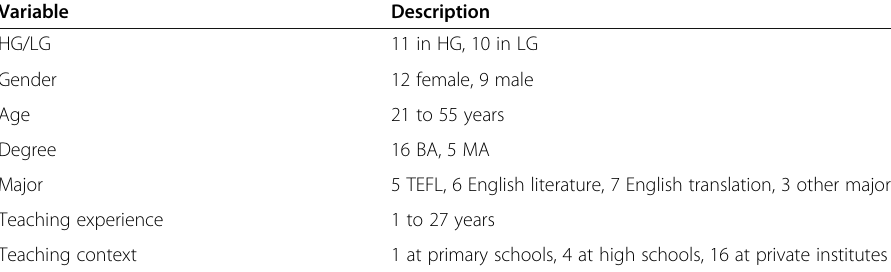
Table 1 Demographic information of the participant